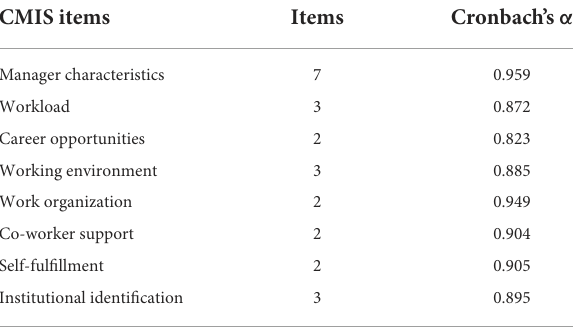
TABLE 1 Cronbach’s α of CMIS